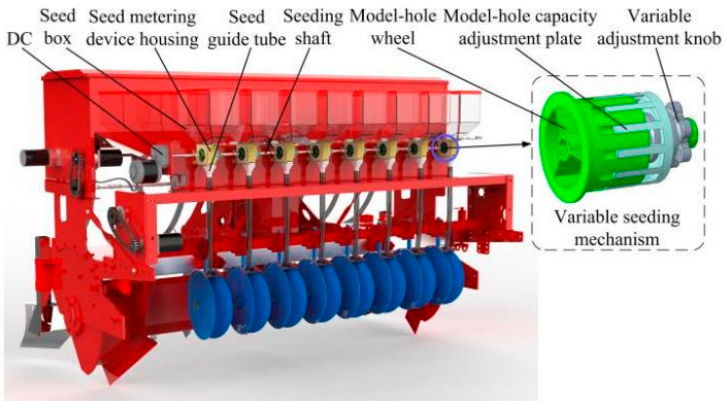
Figure 1. Mechanical variable direct seeder for wheat.